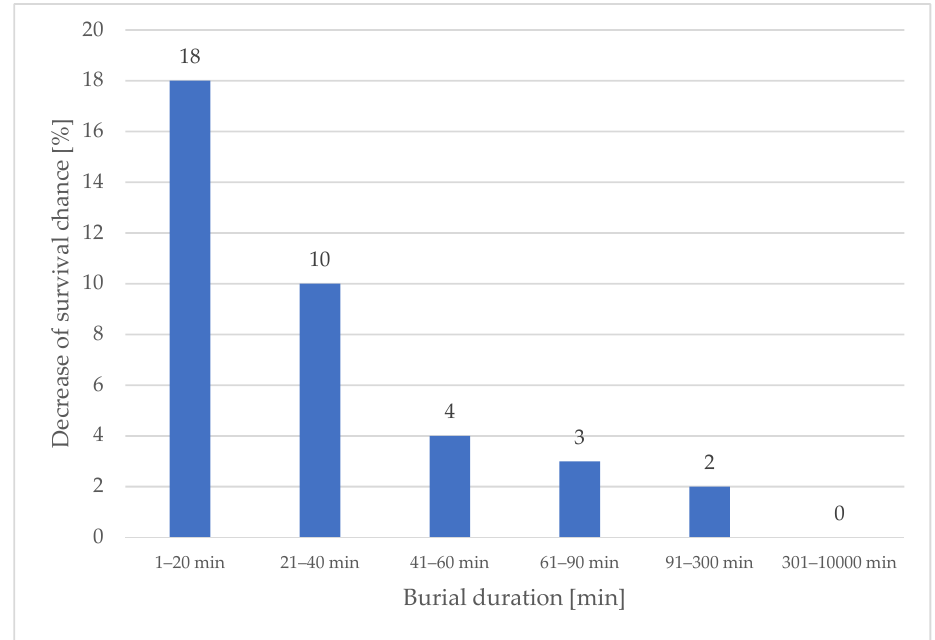
Figure 3. Decrease in survival chances in % per meter of burial depth (N = 1012).